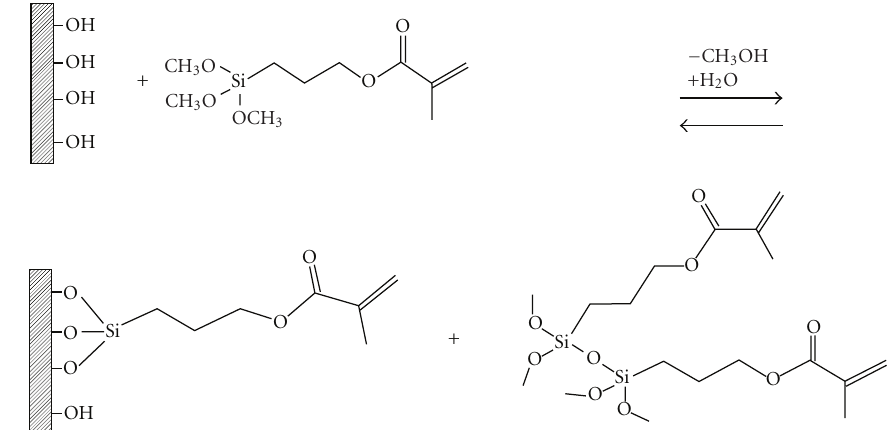
Scheme 2: Schematic presentation of grafting of 3-metacryloxypropyltrimethoxysilane (MPS) to OH-groups of the Sb:SnO 2 particle surface and formation of MPS oligomers.